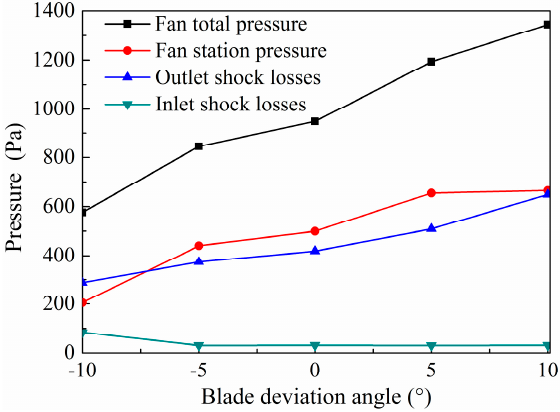
Figure 15. Pressure under different fan blade installation angle conditions.